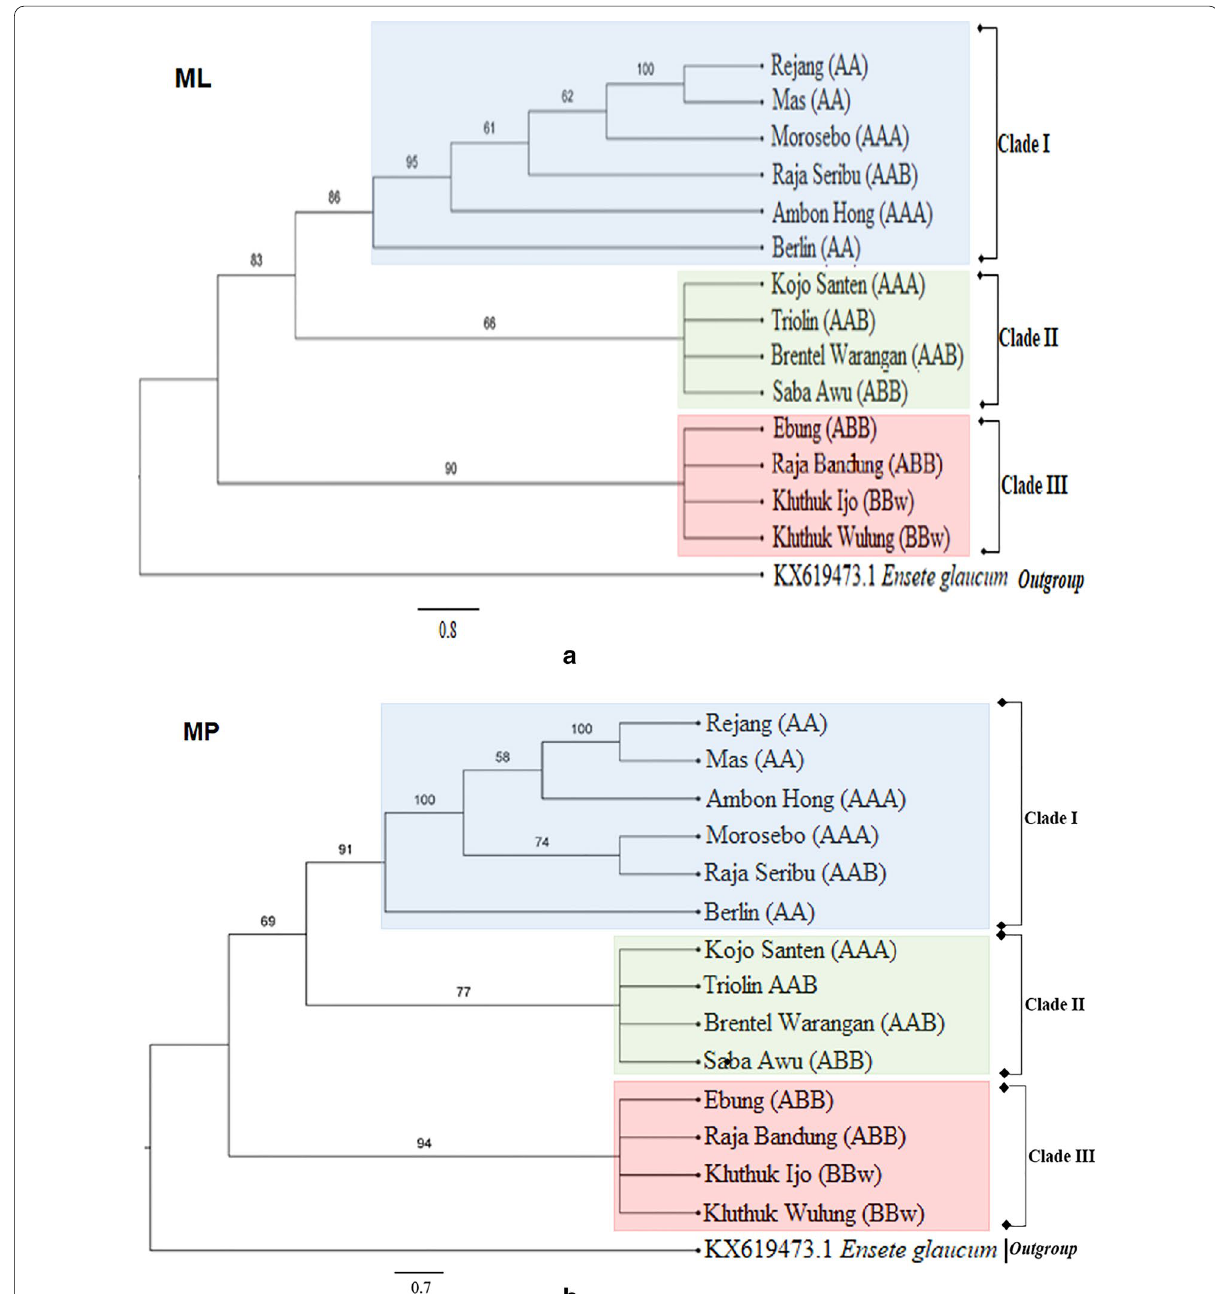
Fig. 4 Phylogenetic trees of 14 banana cultivars infered from mat K gene using different algorithms. ( a ) Maximum likelihood (ML). ( b ) Maximum parsimony (MP). ( c) Bayesian inference (BI). Numbers associated with branches are bootstrap percentages of ML and MP higher than 50% and Bayesian posterior probabilities greater than 0.90, respectively. Each cultivar name was followed genome composition of the cultivar which the previously recognized. Ensete glaucum used as